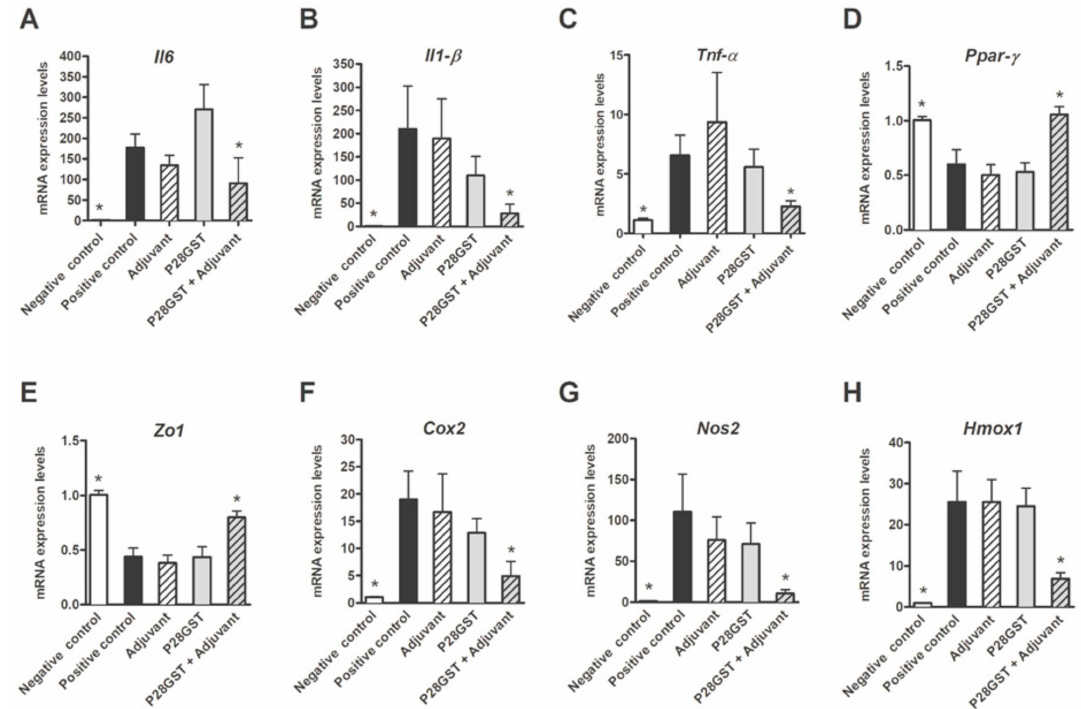
Figure 2. Mice receiving P28GST + Adjuvant exhibited a reduced inflammatory transcriptional signature when compared to the positive control, as well as in groups with adjuvant or P28GST alone. ( A ) Interleukin-6 ( IL6 ), ( B ) interleukin IL1- β , ( C ) tumor necrosis factor alpha ( TNF- α ), ( D ) peroxisome proliferator activated receptor- γ ( Ppar- γ ), ( E ) Zonula occludens-1 ( Zo1 ), ( F ) Cyclo-oxygenase-2 ( Cox-2 ), ( G ) Nitric oxide synthase ( Nos-2 ), and ( H ) Heme oxidase-1 ( Hmox1 ) mRNA expression was assessed by quantitative PCR in the colons from the five groups of mice. Results are expressed as means ± SEM; n = 10 mice per group; * p < 0.05; NS, not significantly di ff erent from the positive control